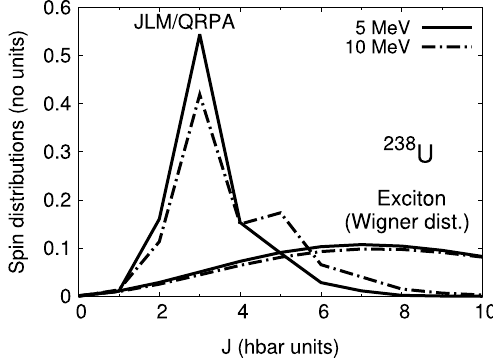
Fig. 4. Compound nucleus spin distribution of the 238 U compound nucleus formed after a fast neutron emission. The Wigner distribution associated to the exciton model is compared to the QRPA-based approach of